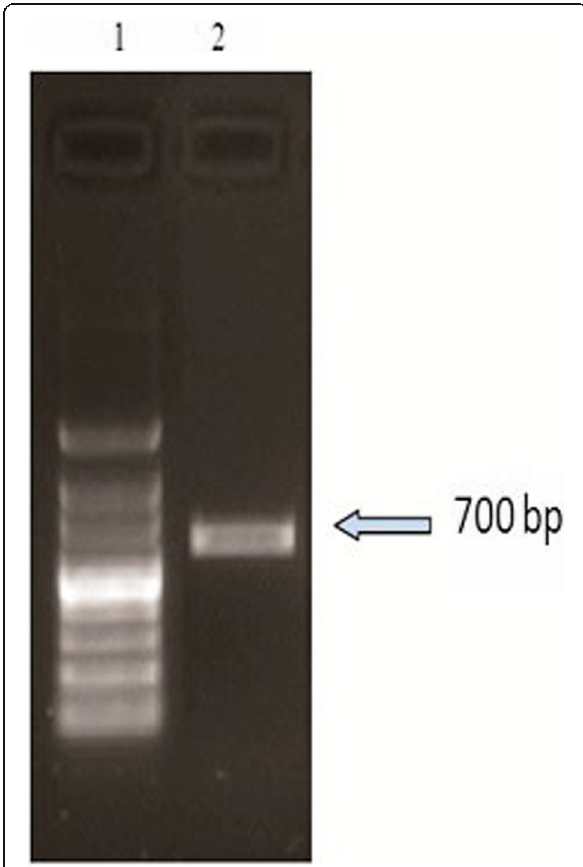
Fig. 3 1.2% agarose gel showing single 700-bp D2 region of 28S rDNA amplicon band. Lane 1: DNA marker (1-kb ladder). Lane 2: 28S rDNA amplicon of fungal